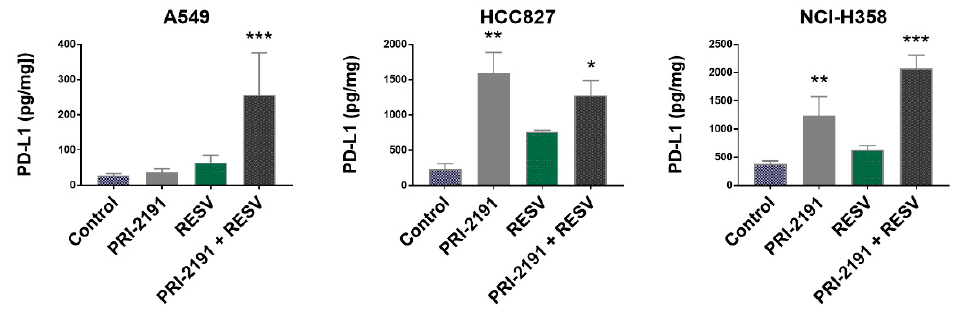
Figure 9. Effect of PRI-2191 and RESV on programmed death-ligand 1 (PD-L1) expression by lung cancer cells. RESV was used at a concentration of 20 µ M and PRI-2191 at 100 nM. Cells were exposed to tested compounds for 72 h, then washed with PBS, and cultured in a serum-free medium for the next 24 h. Cells were collected, and the level of PD-L1 in lung cancer cells was measured by ELISA. * Compared to control (untreated cells); ** compared to control and RESV; *** compared to control, PRI-2191, and RESV ( p < 0.05, one-way ANOVA with Tukey’s post hoc with multiple